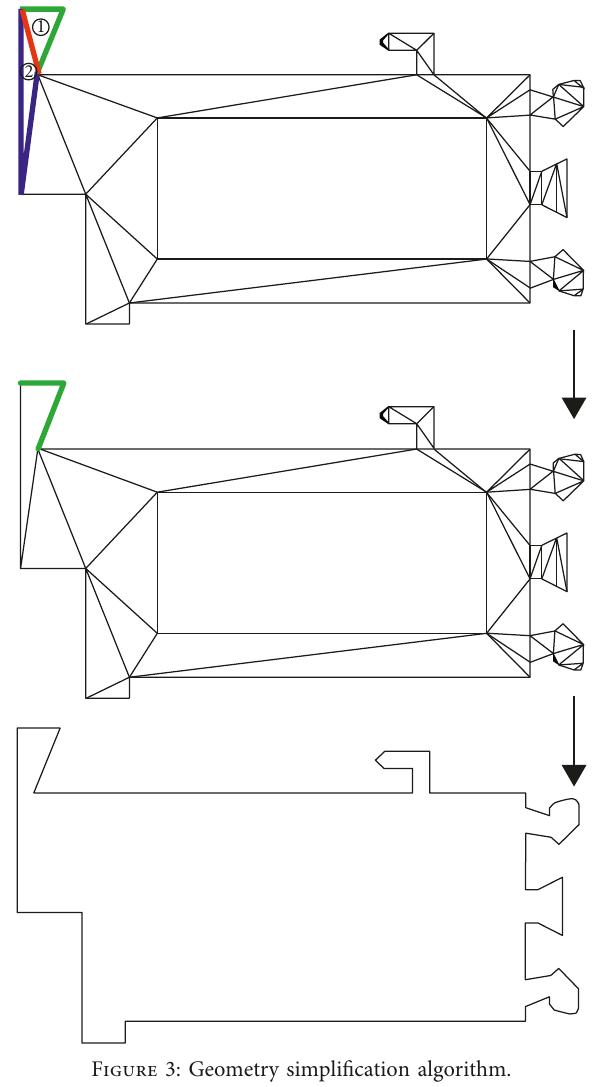
Figure 3: Geometry simplification algorithm.